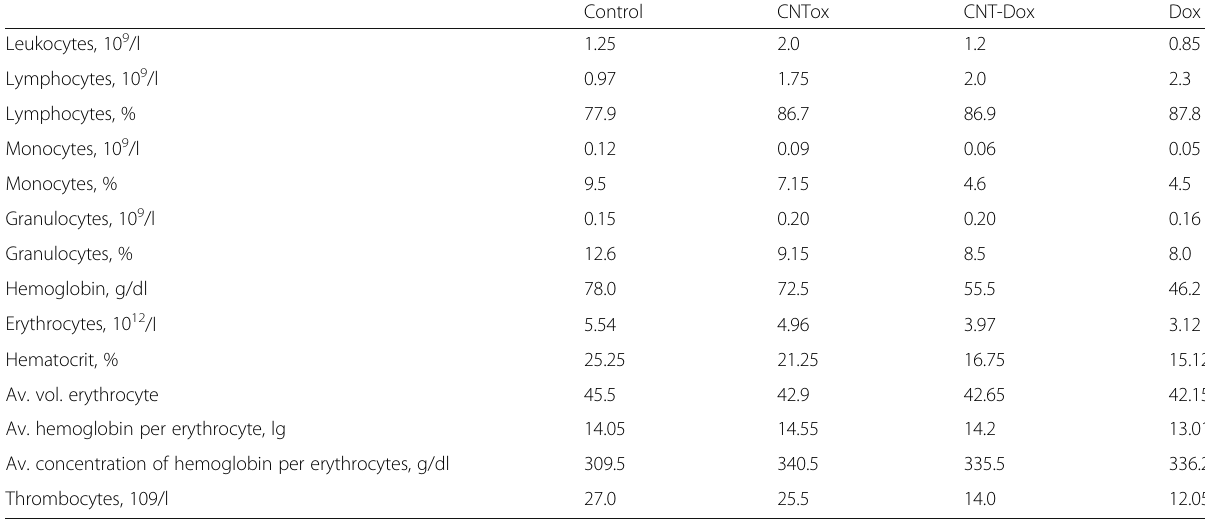
Table 3 Composition of the formed blood elements in the experimental animals after 4 weeks of administration of CNTox and CNT- Dox